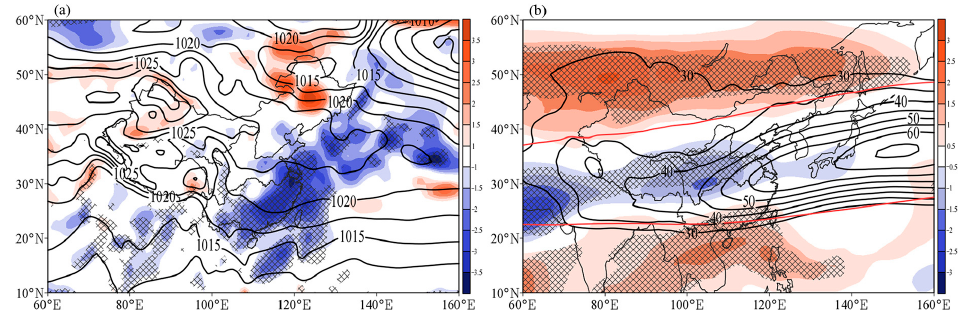
Figure 6. ( a ) The composite of original sea level pressure (SLP) (contours, unit: hPa) and standard anomalies of the absolute gradient of SLP (shaded) from 24 November to 3 December in 2018. ( b ) The composite analysis of original 200 hPa u winds (Only values more than 30 m · s − 1 is shown as contours) and standard anomalies of 200 hPa u winds (shaded) from 24 November to 3 December in 2018. The red line in ( b ) is the climatological u = 30 m · s − 1 at 200 hPa. The crossed area in each panel denotes anomalies exceeding the 0.01 significance